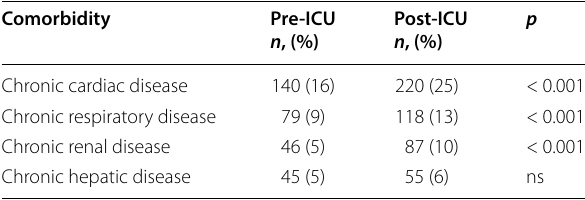
Table 2 Comparison of the reported comorbidities